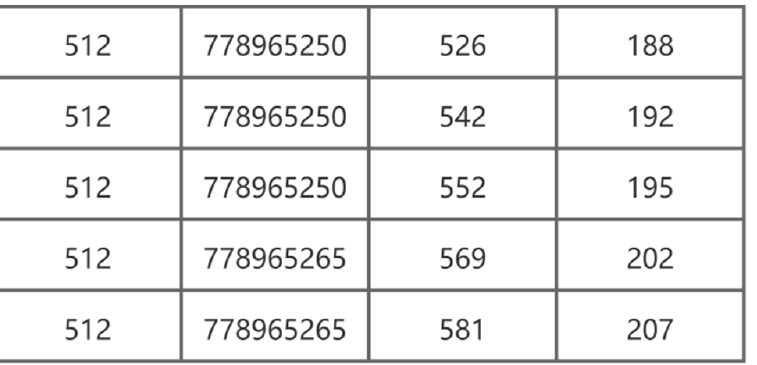
Figure 4. Example of collected keystroke data.